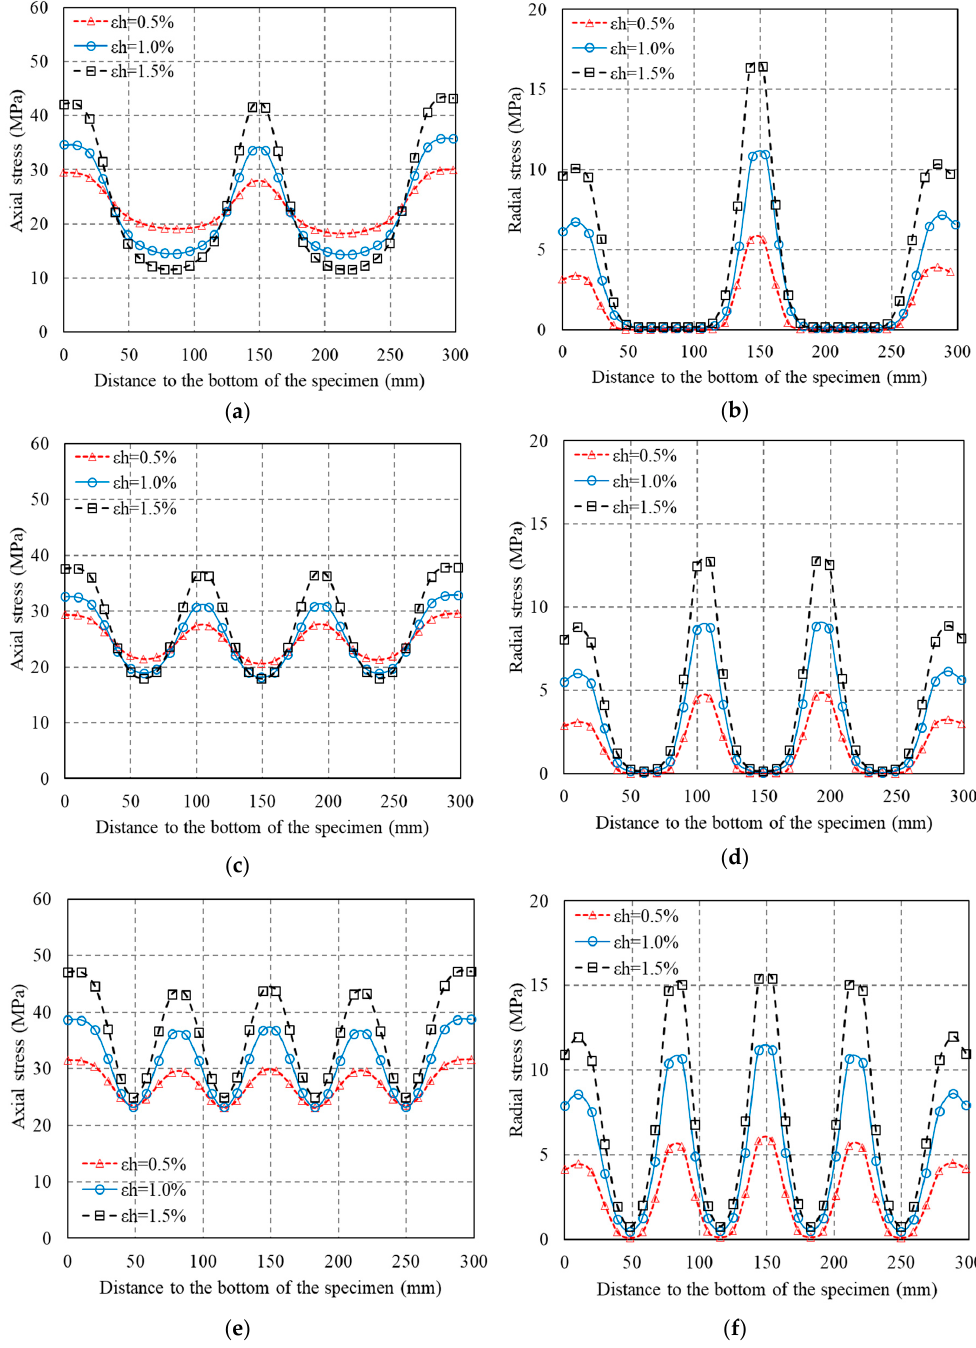
Figure 19. Axial stress and radial stress distributions along the generatrix (column height). ( a ) Axial stress (S-2-3-30); ( b ) Radial stress (S-2-3-30); ( c ) Axial stress (S-2-4-30); ( d ) Radial stress (S-2-4-30); ( e ) Axial stress (S-2-5-30); ( f ) Radial stress (S-2-5-30). To further validate the arching action, the axial stress distribution along the radial direction (X axis) is given in Figure 20, with the axial stresses being drawn in the vertical axis and the radial coordinate being drawn in the horizontal axis. It is also obvious that in the mid-plain of each FRP strip, the axial stress distribution along the radial direction is more uniform than that in the mid-plain